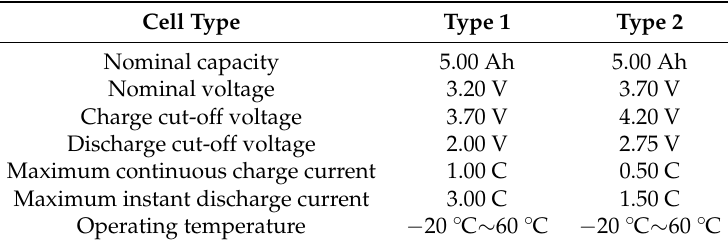
Table 1. The main specifications of LIB cells under